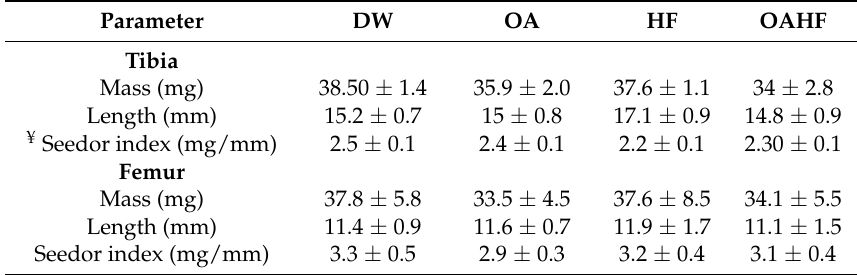
Data presented as mean ± standard deviation. DW = gavaged daily with 10 mL/kg body mass of Mass (mg) distilled water with 0.5% ( v/v ) dimethyl sulphoxide in the neonatal phase ( n = 8); OA = gavaged daily with 10 mL/kg body mass of oleanolic acid (60 mg/kg) in the neonatal phase ( n = 8); HF = gavaged daily with 10 mL/kg of 20% ( w/v ) fructose solution in the neonatal phase ( n = 7); OAHF = gavaged daily with 10 mL/kg body mass of oleanolic acid (60 mg/kg) and 20% ( w/v ) fructose solution in the neonatal period ( n = 7). ¥ Seedor index = bone density in mg/mm.